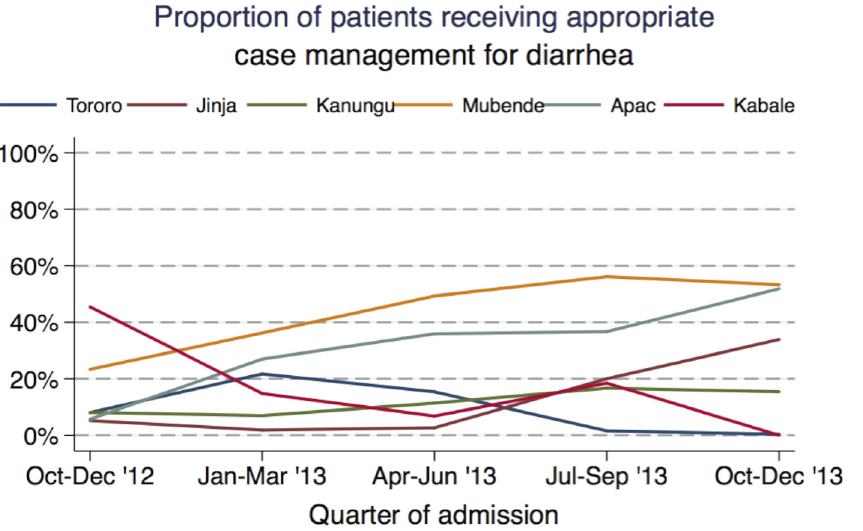
Fig 5. Trends in appropriate inpatient case management of diarrhea, by health